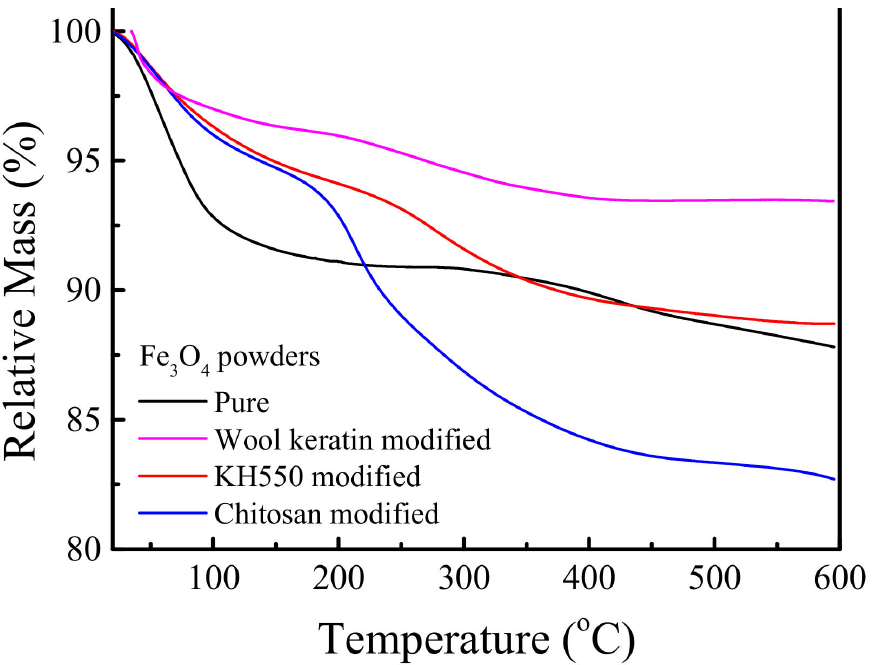
Figure 6. Thermogravimetric (TG) curves of the pure, wool keratin modified, KH550 modified, and chitosan modified Fe 3 O 4